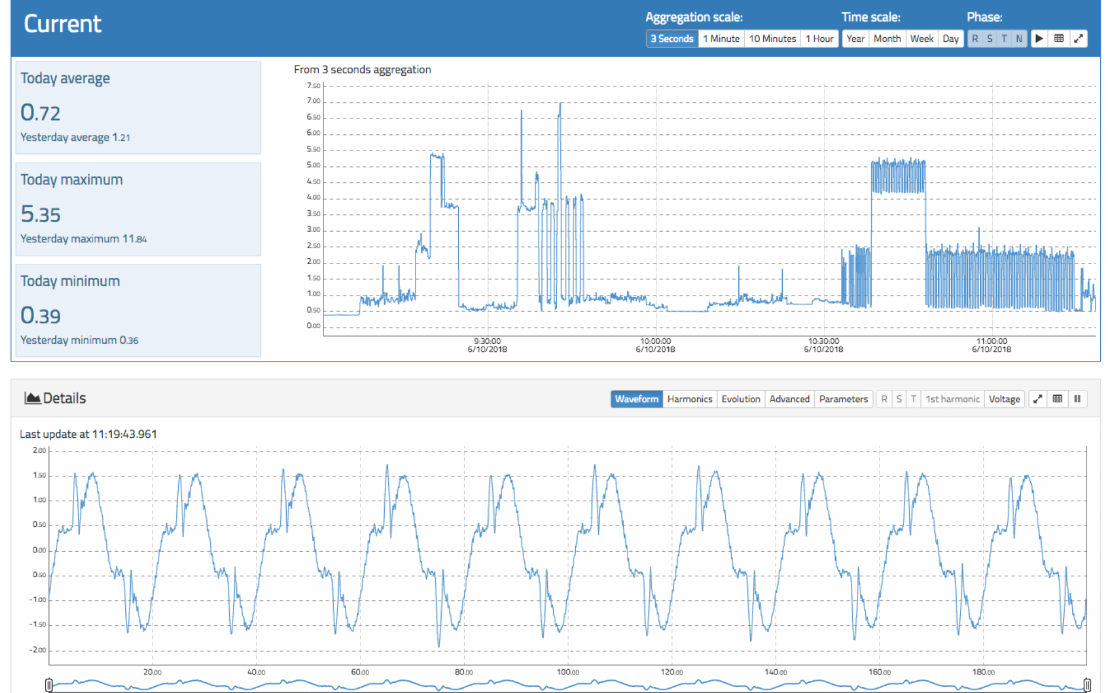
Figure 11. View of root mean square (RMS) and waveform current in